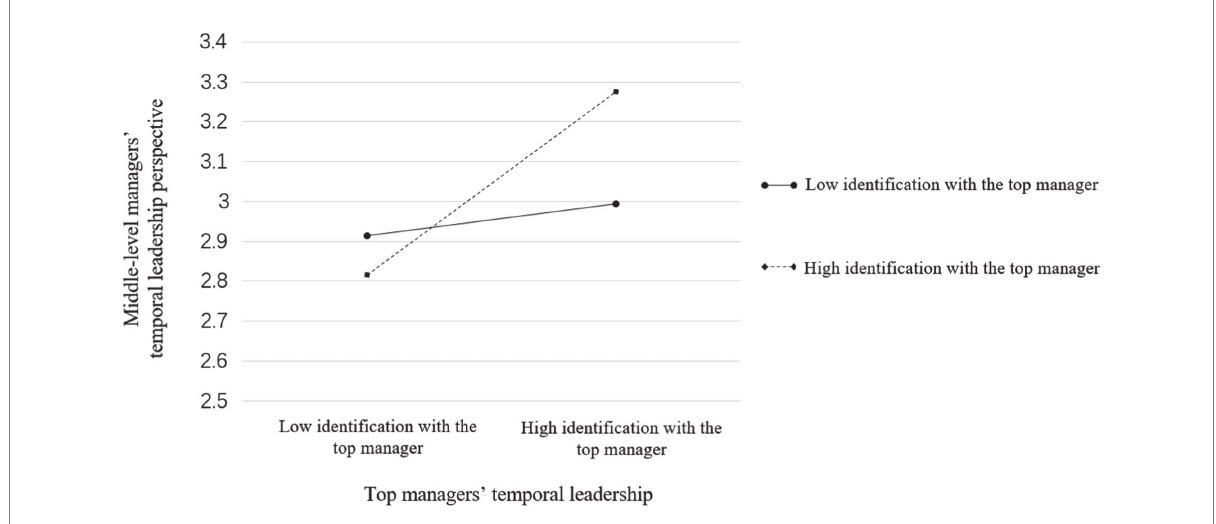
FIGURE 2 The moderating effect of middle-level managers’ identification with the top manager on the relationship between top managers’ temporal leadership and middle-level managers’ temporal leadership